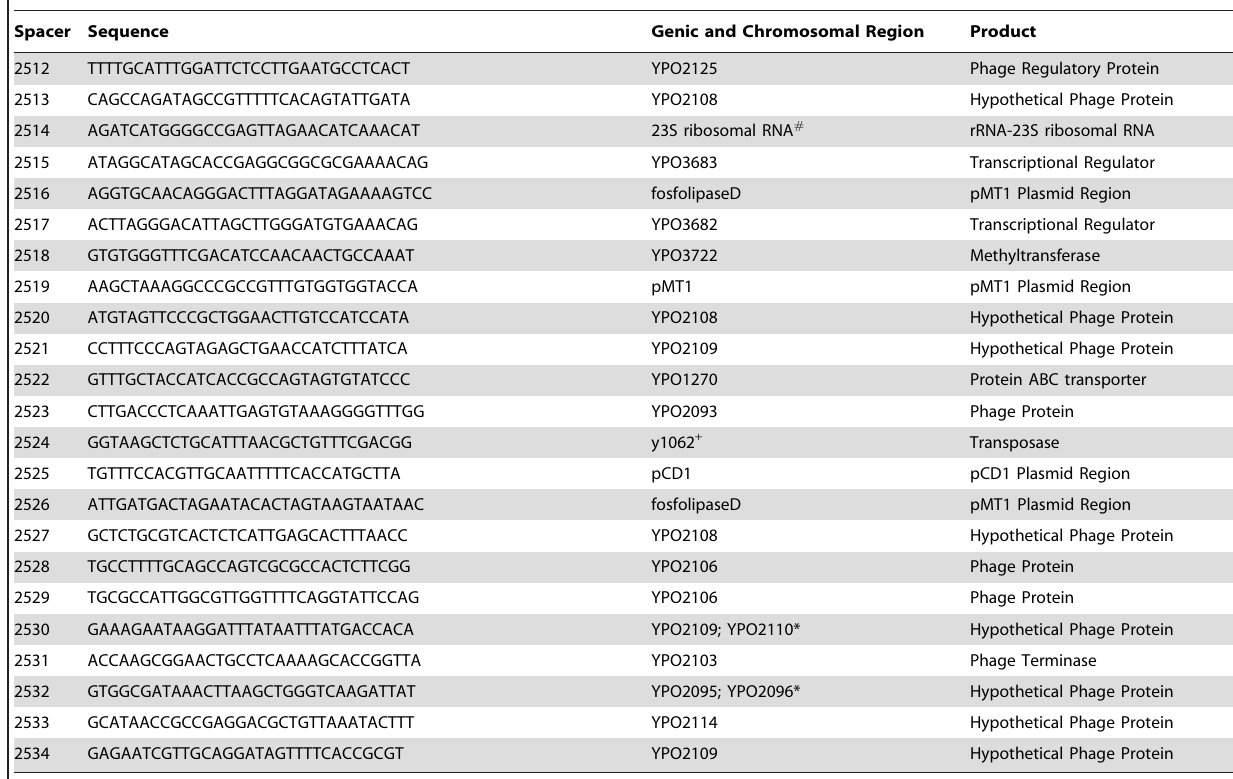
Table 1. Characterization of the new spacers in Yersinia pestis .